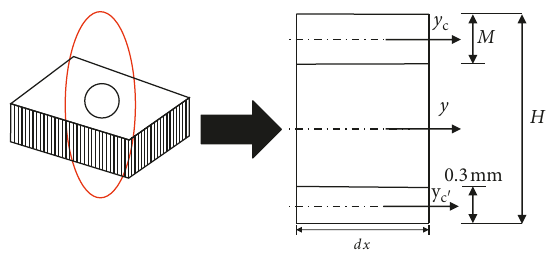
Figure 15: Theoretical